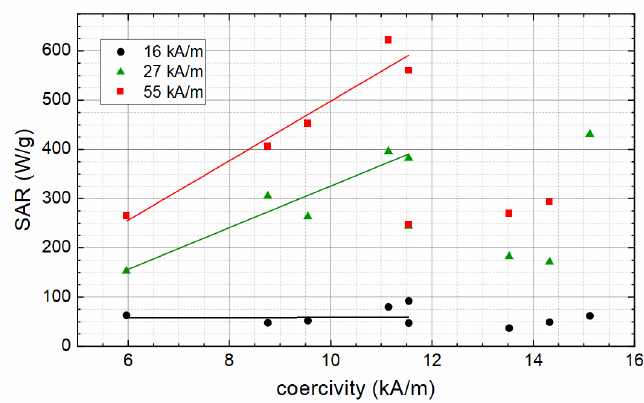
Figure 8. SAR values in dependence of coercivity. Lines serve as a guide to the eye only.